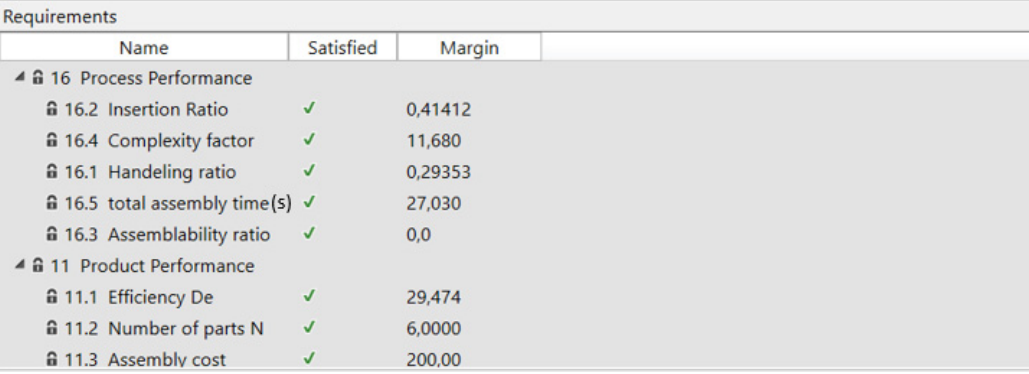
Figure 11. ASP3 response to system specifications.